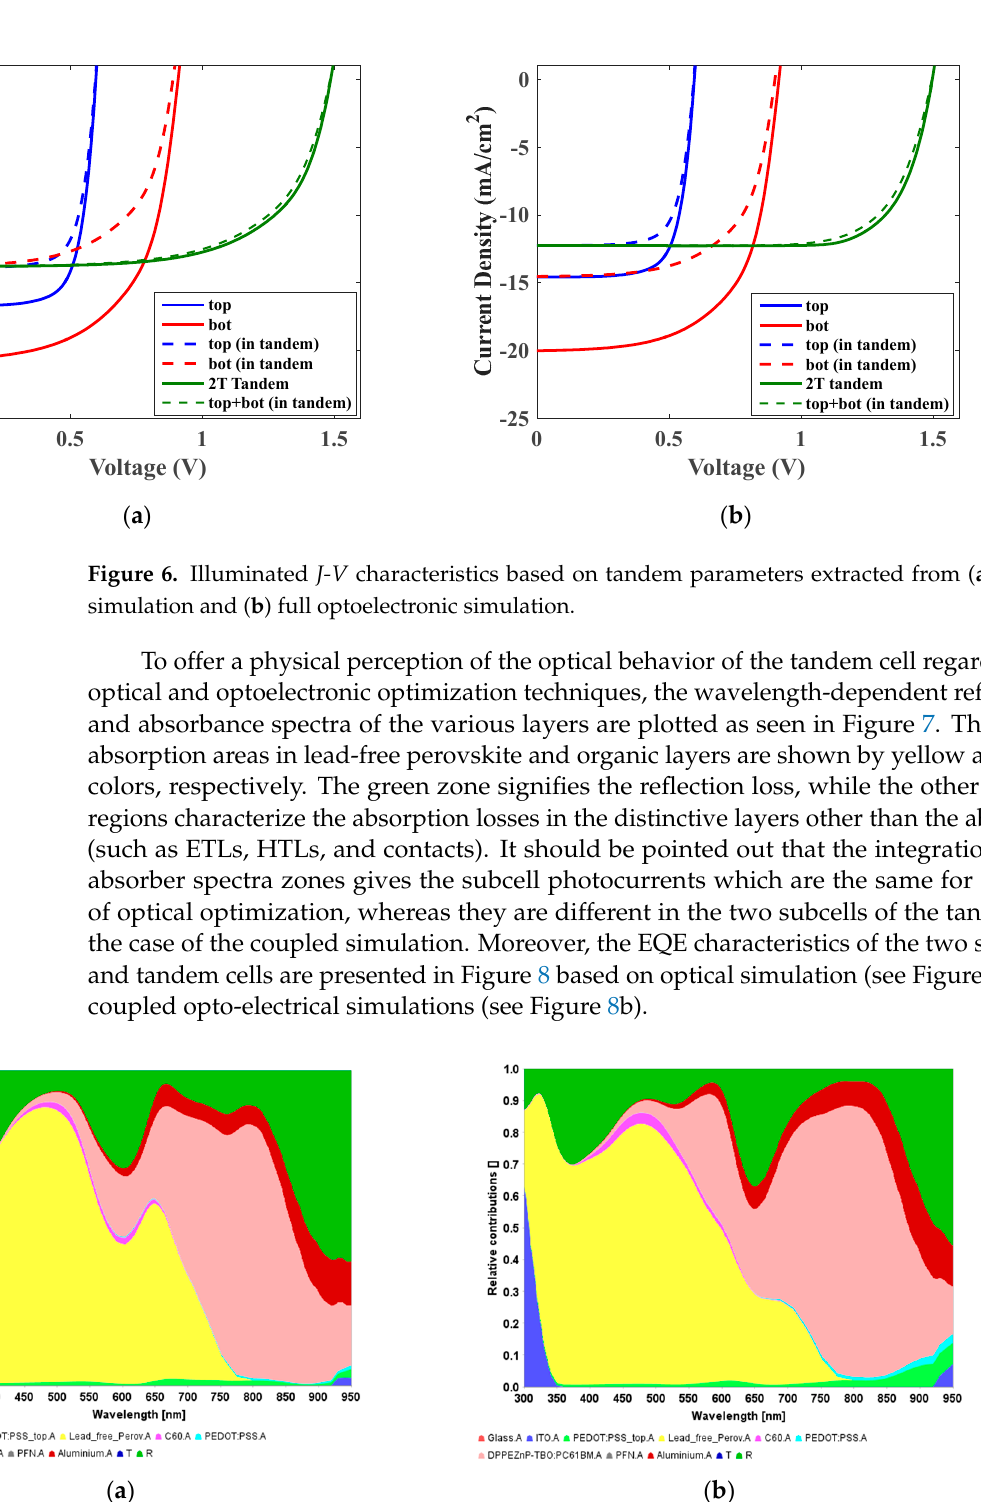
( b ) Figure 5. ( a ) Limiting photocurrent variation vs. the thickness of top ( t top ) and bottom ( t bot ) absorbers based on optical simulation. ( b ) Power conversion efficiency variation vs. the thickness of front and rear absorbers based on full coupled optoelectronic simulation. The black crosses point to the result of the direct global optimization. Based on the optimum values of the thicknesses of the absorbers, the J-V curves of the optical and optoelectronic optimizations are plotted as displayed in Figure 6a,b, re- spectively. The figures display the illuminated characteristics of the individual single junction cells, the filtered subcells and the comparison of the full tandem characteristics with the sum of the filtered subcell curves (which assumes a perfect loss-free intercon- nect). Further, the major performance metrics of the tandems are listed in Table 2. Regard- ing optical optimization, one can observe a situation with a greater short circuit current, but the electrical performance is worse. On the other hand, although the full opto-electri- cal optimization gives a lower J sc , it achieves higher efficiency. The reason is that the non- radiative losses (which are absent in the optics-only model) increase strongly with the